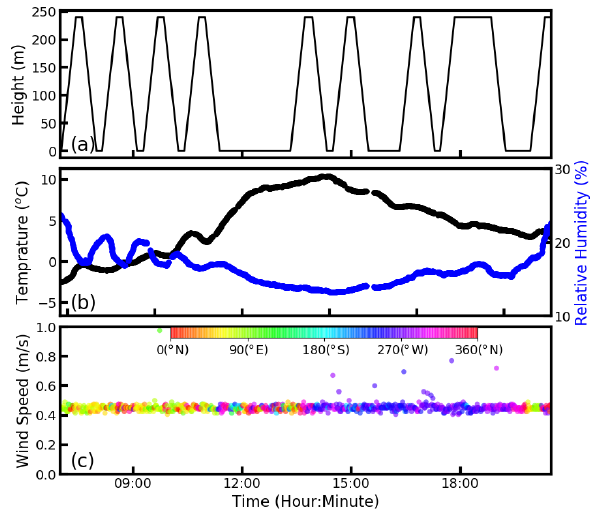
Figure 1. Time series of the (a) measurement altitude, (b) temper- ature (black line) and relative humidity (blue line), and (c) wind speed and wind